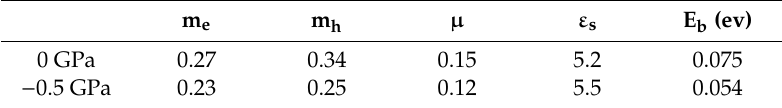
Figure 10. Calculated of e ff ective mass at Z point of conduction band bottom and valence band top of CsGeI 3 under the pressure of 0 GPa and − 0.5 GPa. Table 2. E ff ective masses and exciton binding energy calculated for CsGeI 3 under the pressure of 0 GPa and − 0.5 GPa. Masses are given in units of the free electron mass m